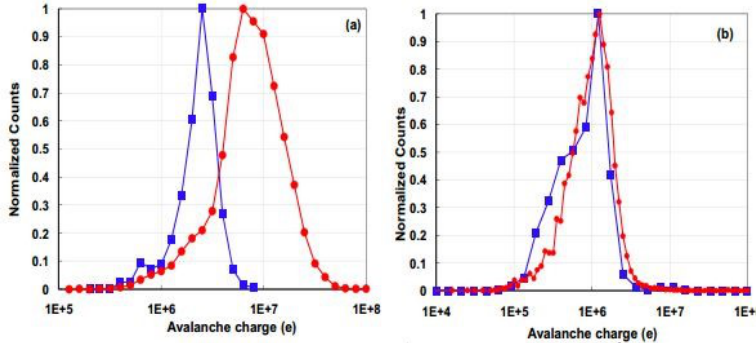
Figure 1: Distribution of total charge (i.e. Geiger-mode gain) in the device over numerous measurements for device design with (a) low re- sistance (90 k Ω ) passive quenching layer typical of traditional passively quenched SPADs at biases of 71.9 V (blue) and 72.6 (red) , and (b) high resistance passive quenching layer typical of NFAD design at biases of 78.0 V (blue) and 80.5 V (red). Higher resistance (i.e. 2.8 M Ω ) passive quenching is shown to make the total device charge (Geiger-mode gain) relatively independent of the overbias, and a lower amount of charge (10 6 ) with larger quenching resistance helps reduce the afterpulsing rate compared to lower resistance device operating at a higher amount of charge (mid 10 6 to 10 7 ), as explained next. From